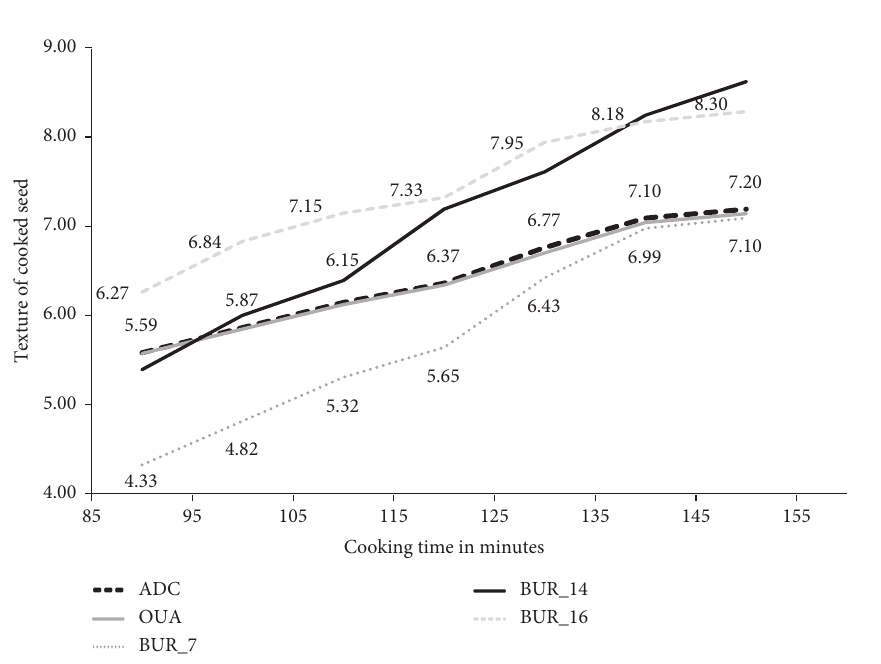
Figure 2: Cooking time- and accession-based changing trend of Kersting’s groundnut seed texture. Table 3: Proximate composition of selected Kersting’s groundnut seed.